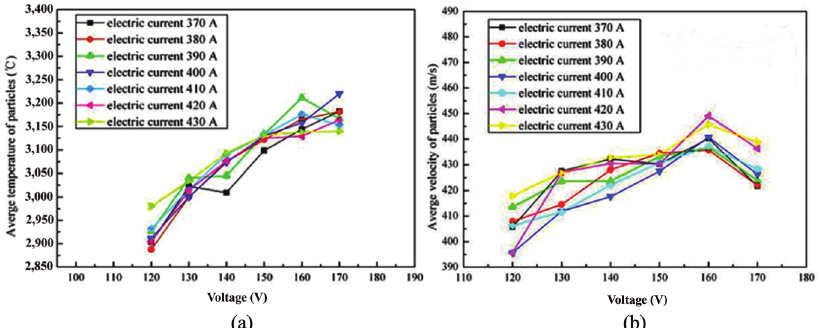
Figure 14: Effects of voltage on (a) parti- cles surface temperature and (b) flight velocity with various current at the spraying distance of 100 mm. In experi- ment, the H 2 volume fraction was 23%, total Ar þ H 2 gas flow rate was 80